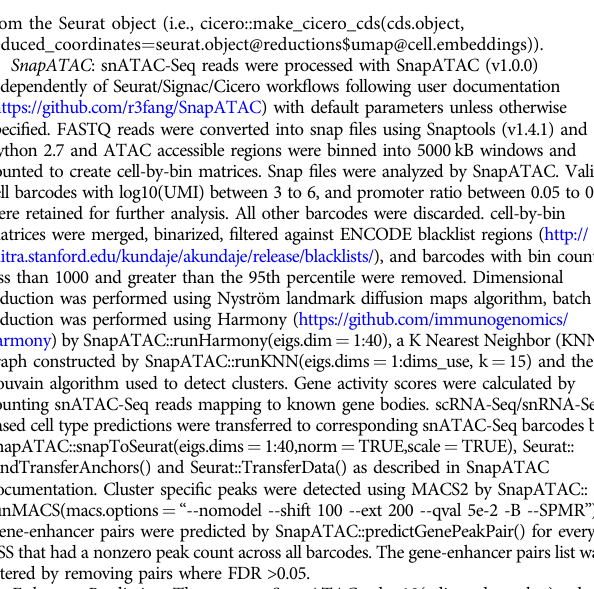
Primary Table: encode3Ren_forebrain_H3K27ac_E12, Big Bed File: /gbdb/mm10/ encode3/histones/ENCFF957YEE.bigBed) or E14.5 (UCSC Database: mm10, Primary Table: encode3Ren_forebrain_H3K27ac_E14, Big Bed File: /gbdb/mm10/ encode3/histones/ENCFF088LWR.bigBed) by